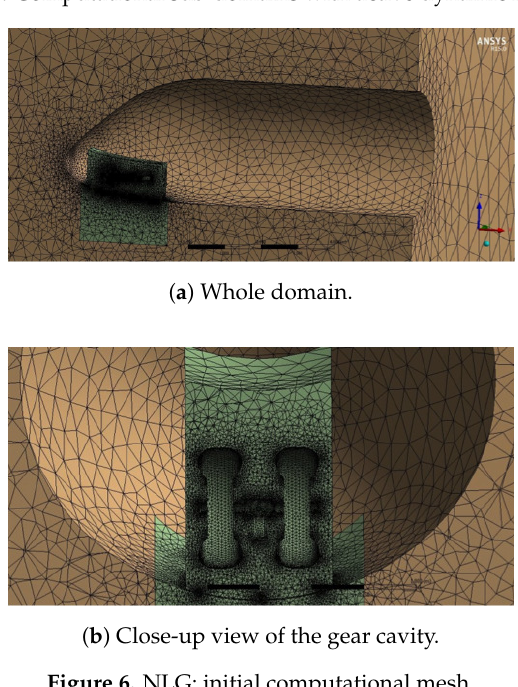
Figure 6. NLG: initial computational mesh.